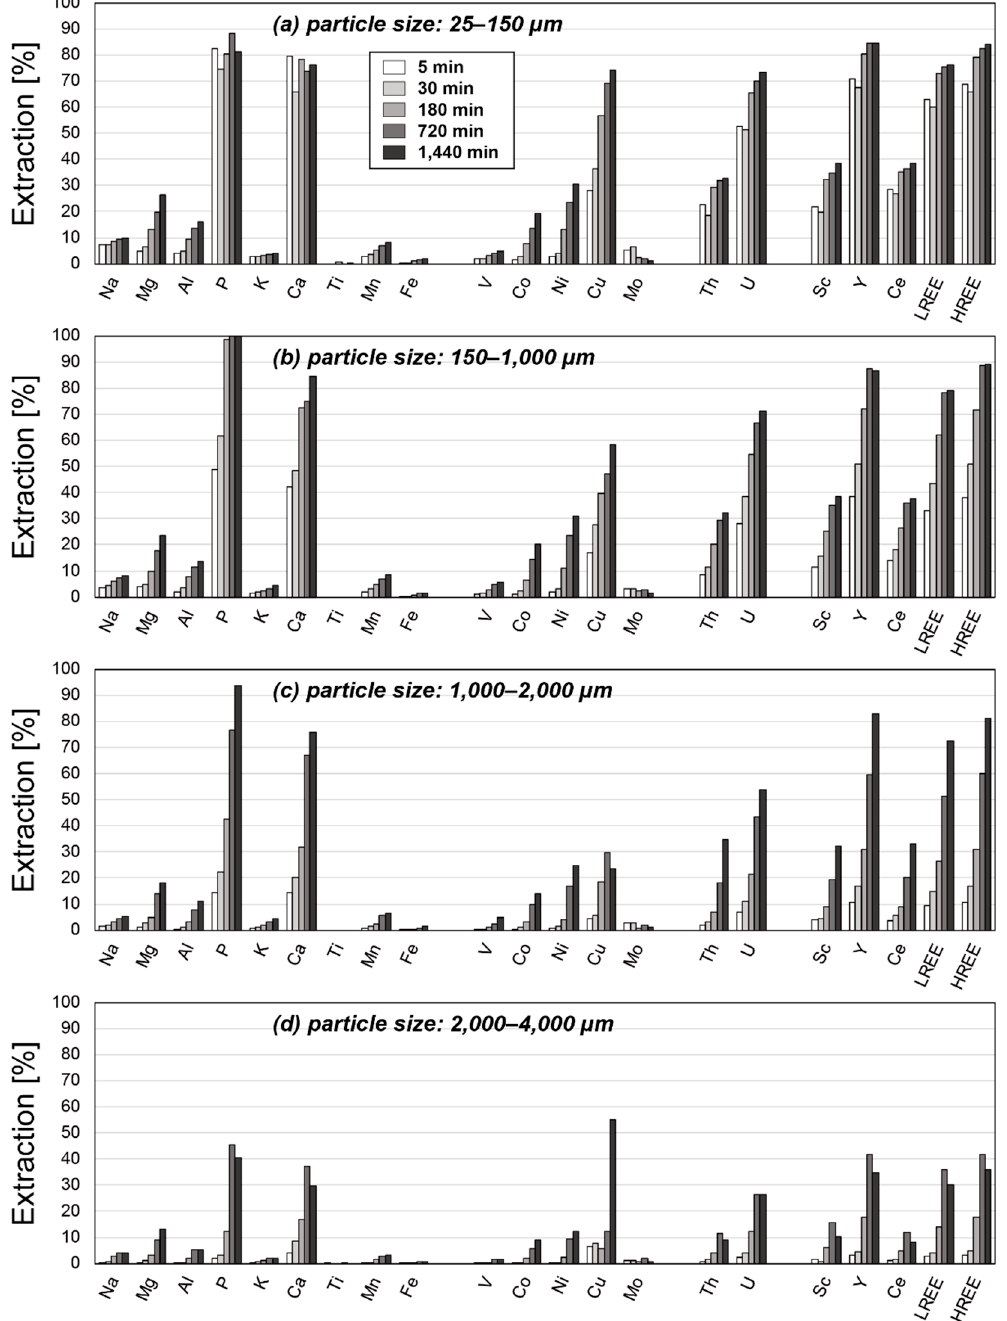
Figure 6. Extraction percentages of major elements, valuable metals, radioactive elements, and REE from the Aki umber as a function of time using sulfuric acid as a leachate. Experiments with the particle size of ( a ) 25–150 μ m, ( b ) 150–1000 μ m, ( c ) 1000–2000 μ m, and ( d ) 2000–4000 μ m.